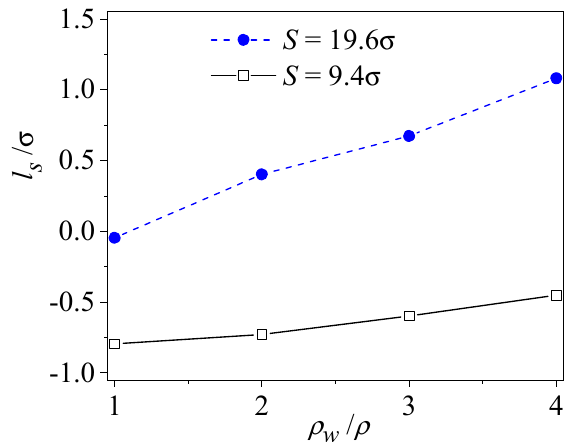
Figure 6. The effect of wall density on slip length ( ε wl = ε , δ = 1.57 σ ).